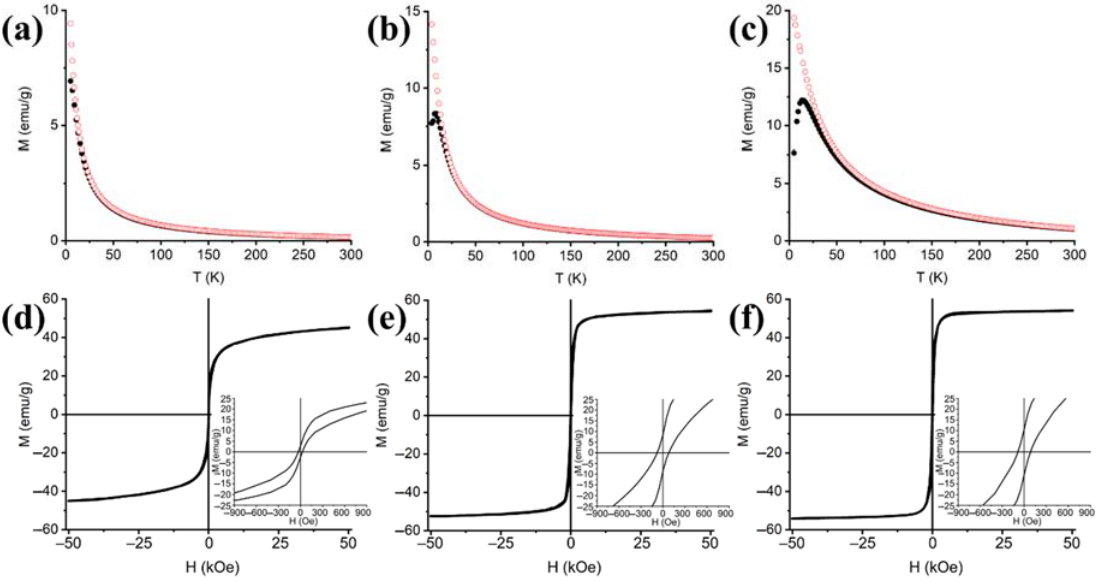
Figure 6. Zero-field cooled-field cooled magnetization curves ( a – c ) and hysteresis cycles ( d – f ) of xerogel samples treated at 900 °C with increasing loading of 5 wt% ( a , d ), 10 wt% ( b , e ) and 15 wt% ( c , f ).